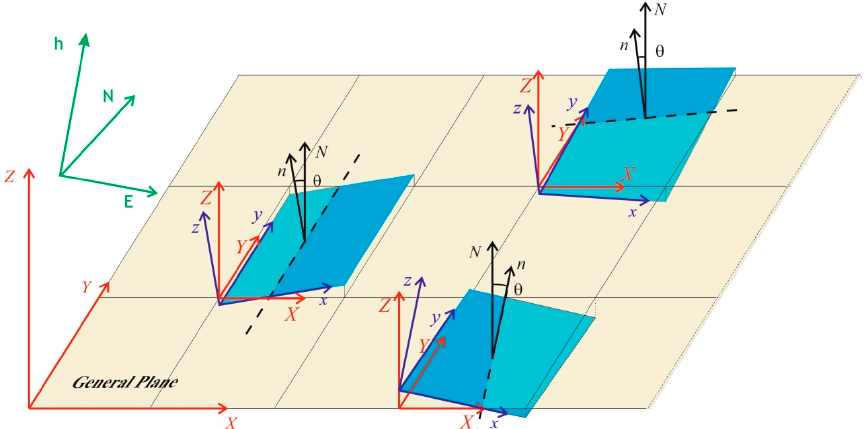
Figure 3. Explanatory drawing of the reference systems used: “absolute” (in green), “general” (in red), “local” (in black) and spatial relationships between them.